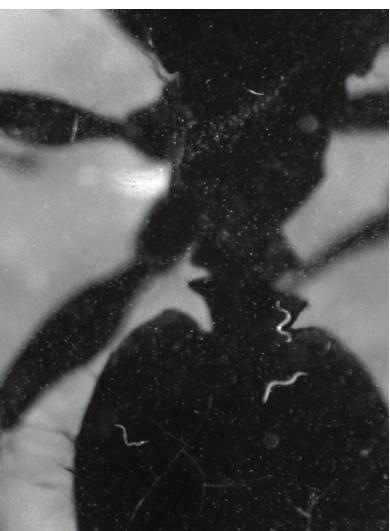
Figure 16: Three juveniles of the allantonematid, Palaeoallan- tonema cephalotae, that emerged from a worker Cephalotes ant in Dominican amber.